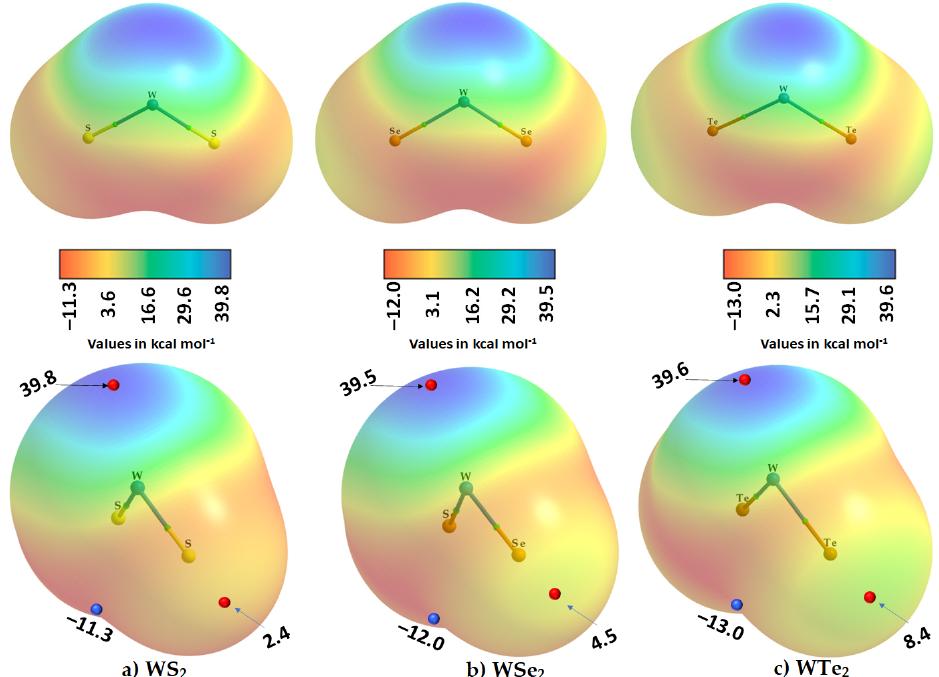
Figure 5. Two different views (top and bottom) of the 0.001 a.u. isodensity envelope mapped poten- tial on the electrostatic surface of the isolated WCh 2 monomers: ( a ) WS 2 , ( b ) WSe 2 , and ( c ) WTe 2 , obtained with M06-2X/Aug-cc-pVTZ(-PP). The tiny red and blue spheres represent the local most maximum and minimum of potentials ( V S,max and V S,min ), respectively. Superimposed in each case is the QTAIM molecular graph.